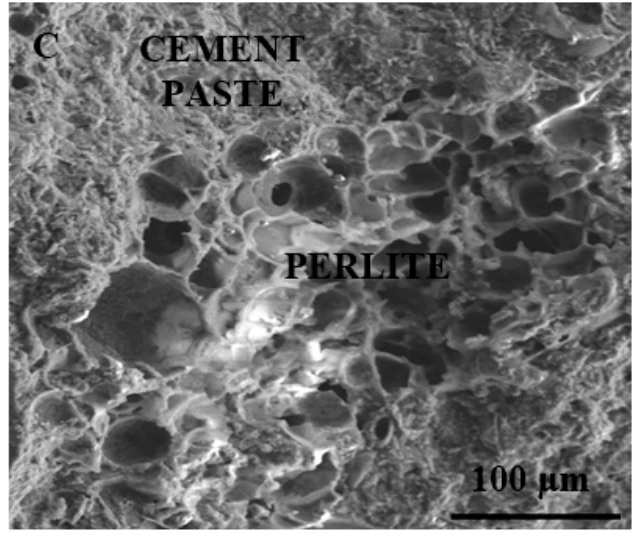
Figure 11. SEM images of ( A ) P/TR F bead, ( B ) cement/TR F interface, ( C ) cement/perlite interface.